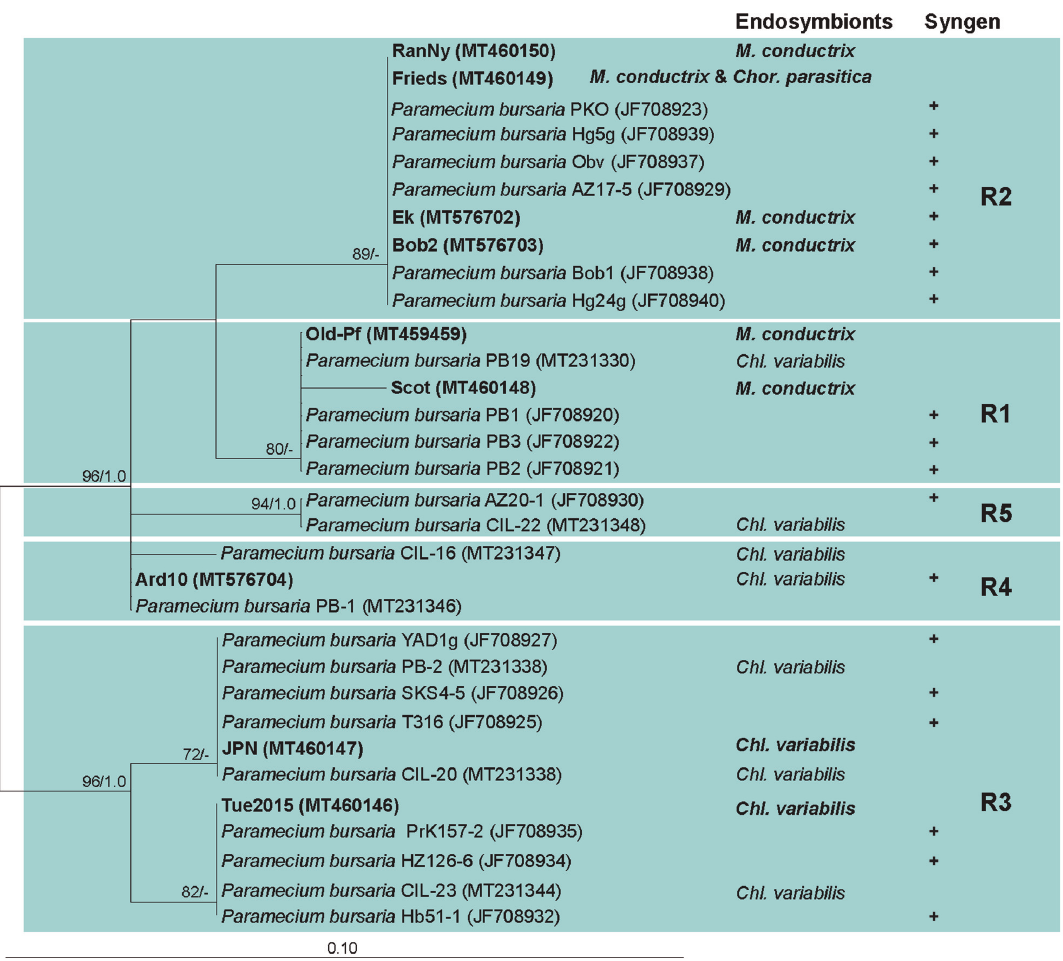
Figure 4. Syngen affiliation of Paramecium bursaria strains based on the internal transcribed spacer (ITS) region spanning ITS1-5.8S-ITS2. Unrooted Maximum likelihood tree based on 506 aligned positions is shown. GTR + I was used as evolutionary model. Bootstrap values above 70 % and Bayesian Inference values above 0.95 are indicated. The five syngens are highlighted as R1 to R5, a plus marks a strain whose mating behaviour was previously experimentally determined. The identity of the algal symbiont if known is provided. Sequences marked in bold were obtained in this